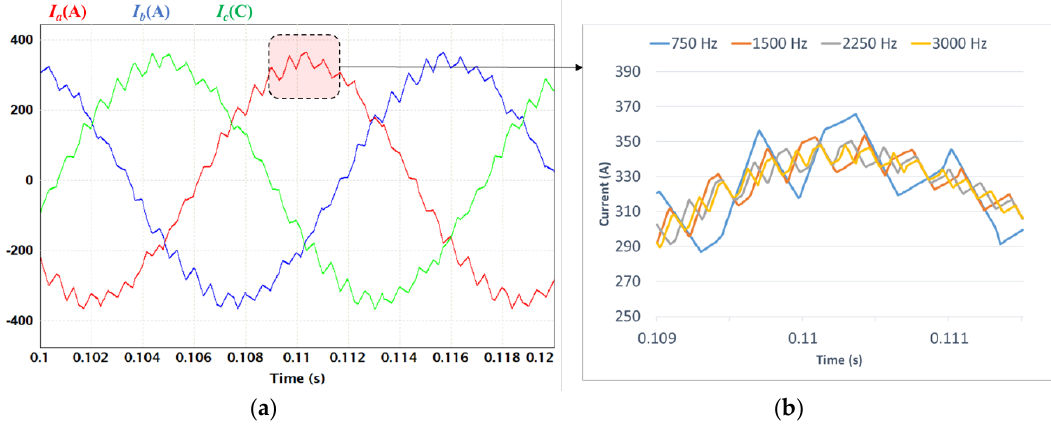
Figure 12. The currents injected to IPMSM at 1200 r/m: ( a ) injected three-phase current at 750 Hz; ( b ) a-phase current depending on switching frequency.